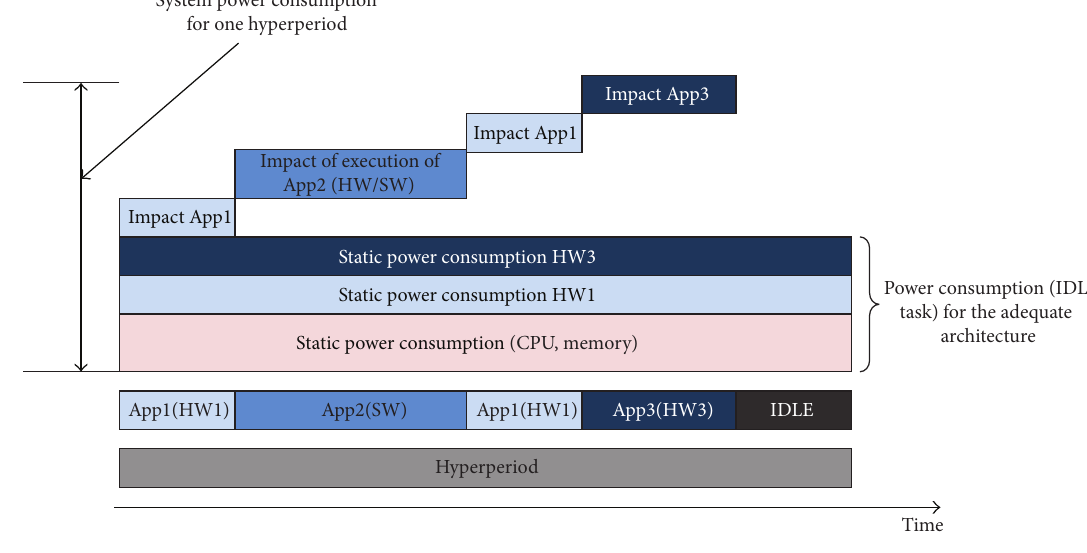
Figure 3: Adopted consumption model.